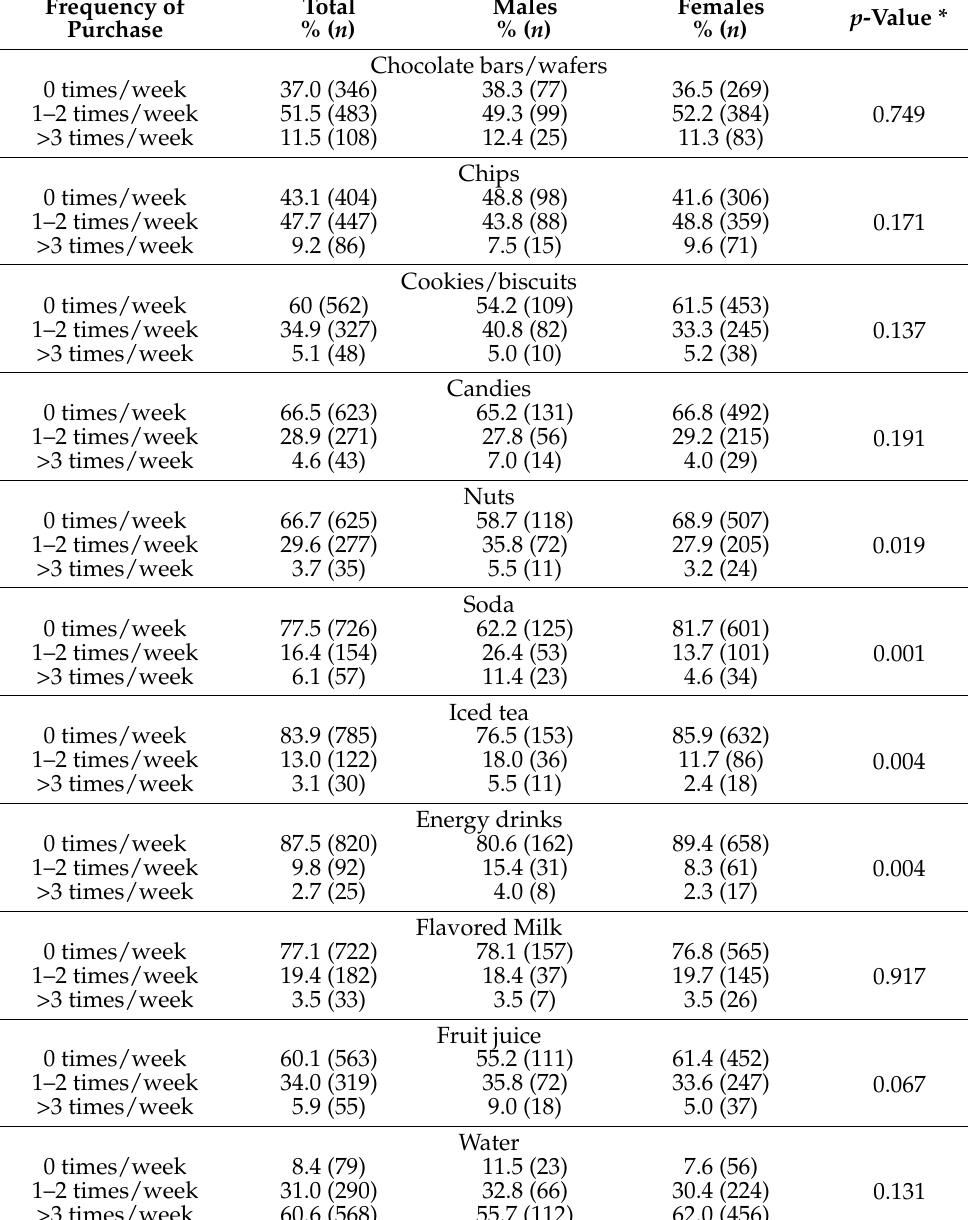
Table 2. Frequency of consumption from the vending machine among users ( n =